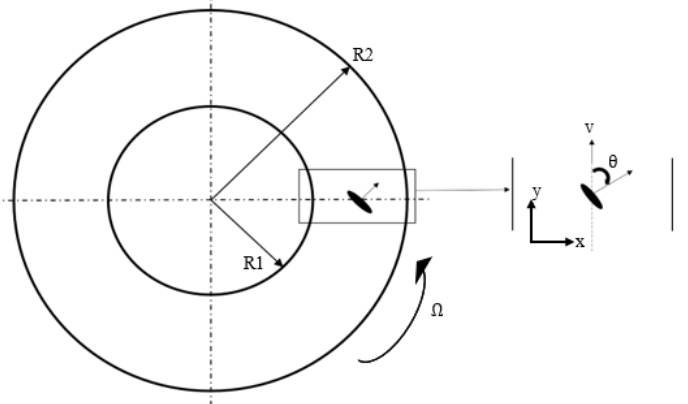
Figure 2. Couette flow geometry with R 1 and R 2 representing the radius of the inner and outer surfaces, respectively.